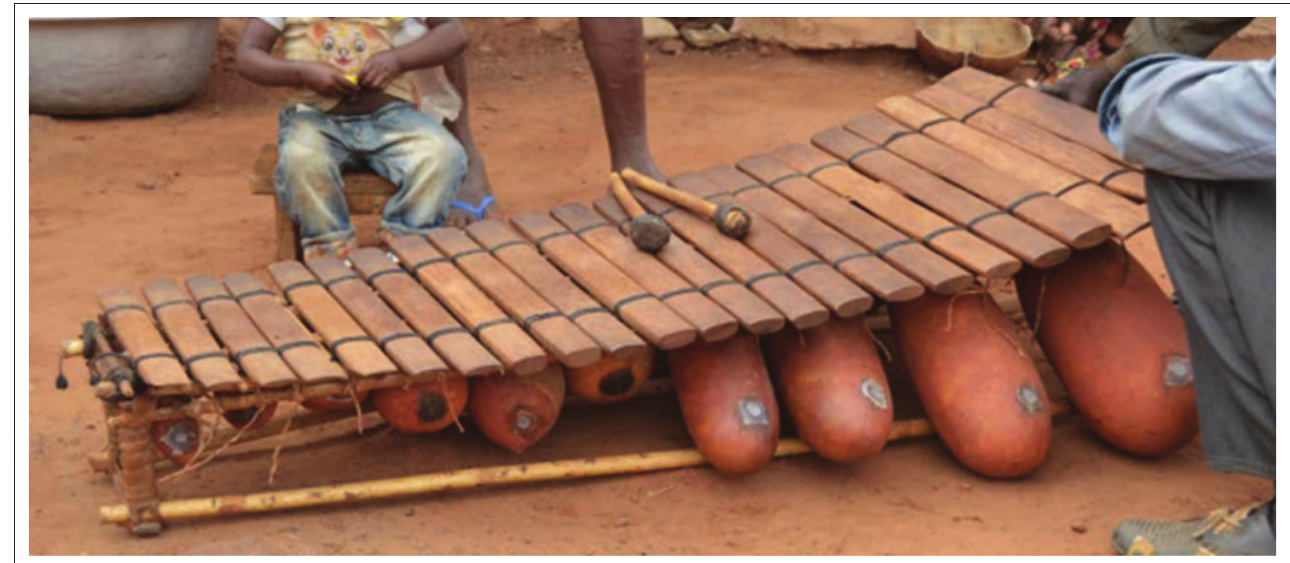
FIGURE 5: Sambla Balafon in Toronso, Burkina